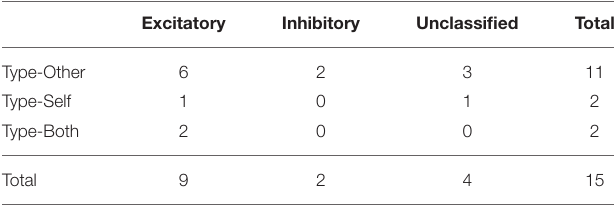
TABLE 1 | Incidence of each type of amygdalar neurons with excitatory or inhibitory responses.